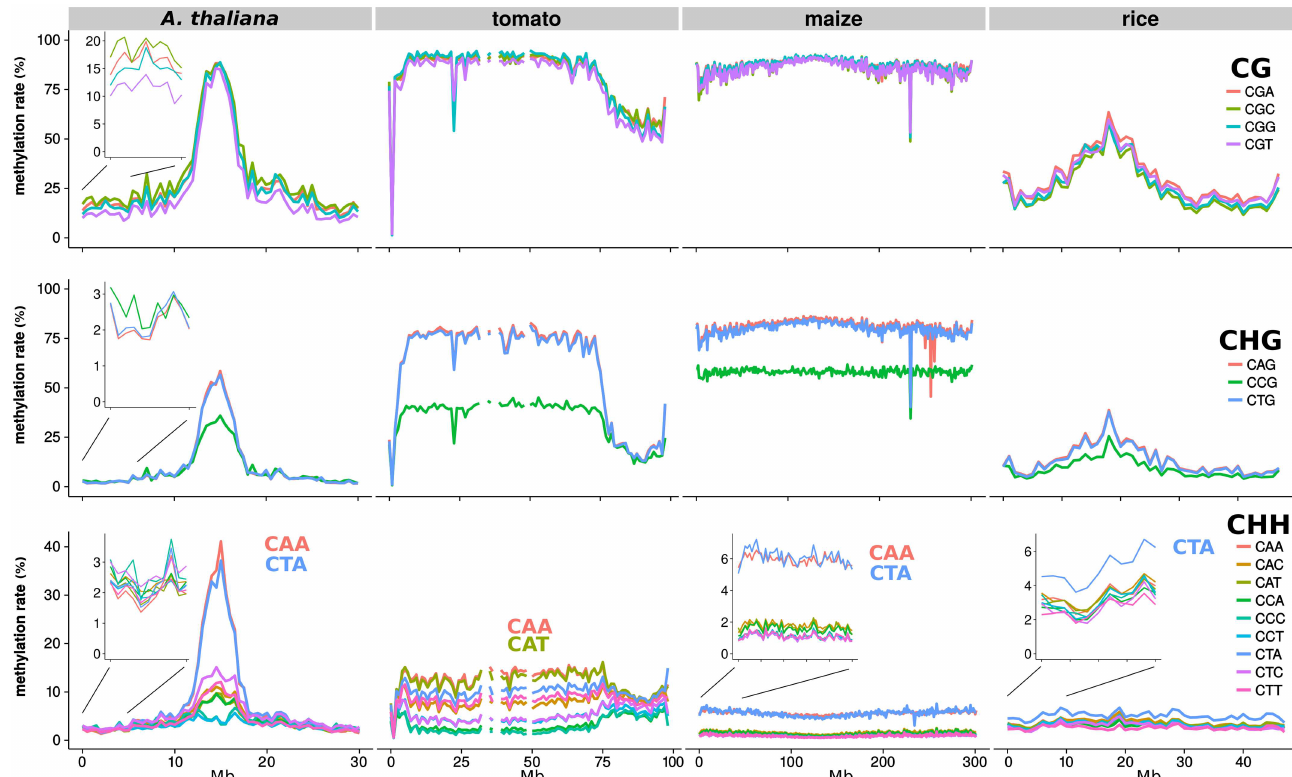
Fig 1. DNA methylation in trinucleotide contexts on chromosome 1 of A. thaliana (Col-0) [13], tomato ( S. lycopersicum cv. M82), maize ( Z. mays B73) [14], and rice ( O. sativa indica) [15] leaves. All chromosomes of these plant species are shown in S1–S4Figs.